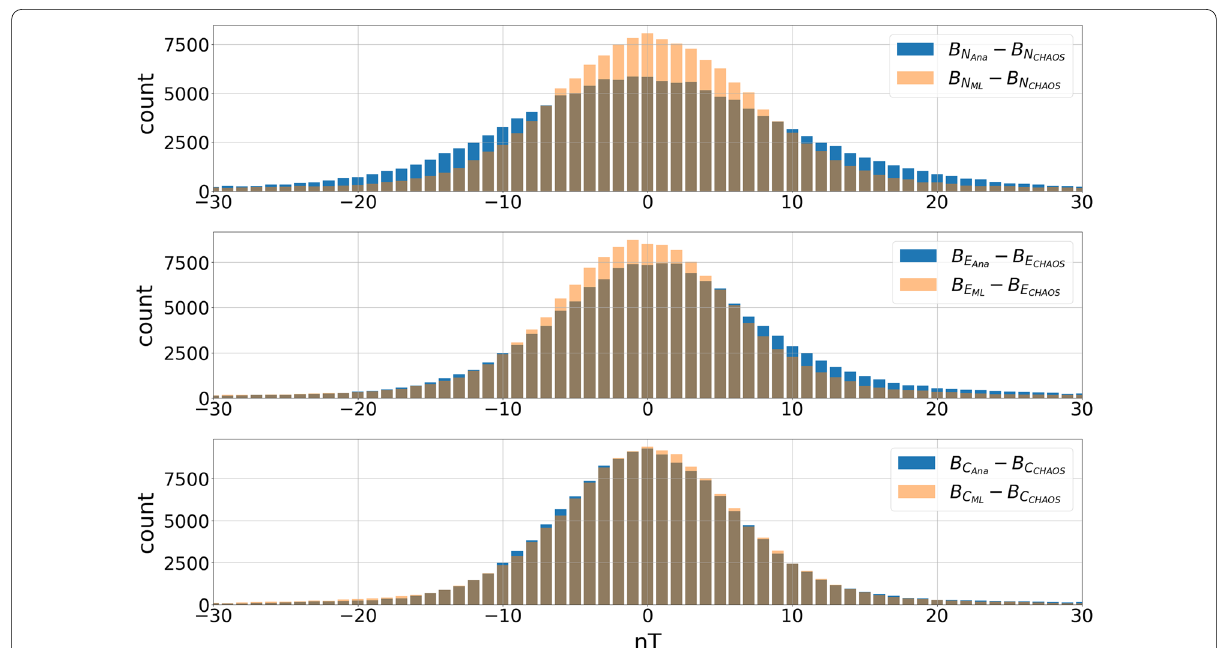
Fig. 7 Residual distribution comparison of the analytical (blue) and ML (orange) based calibrations compared to the CHAOS7 reference model for the December 2009 within a histogram plot with bin sizes of 1nT for the magnetic North (top), East (middle) and Center (bottom) component